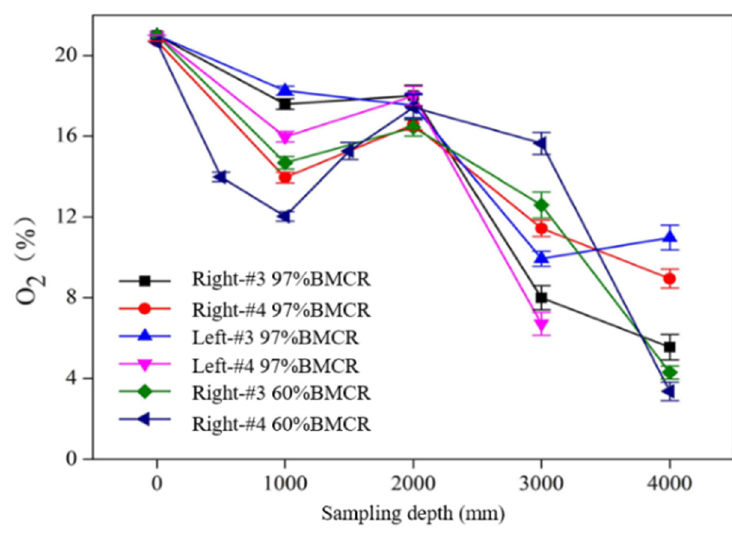
Figure 4. Oxygen distribution of secondary air along horizontal axis.